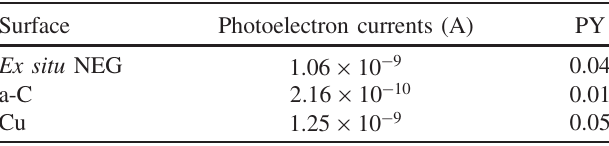
TABLE VI. PY estimation for the three surfaces for 25 ns